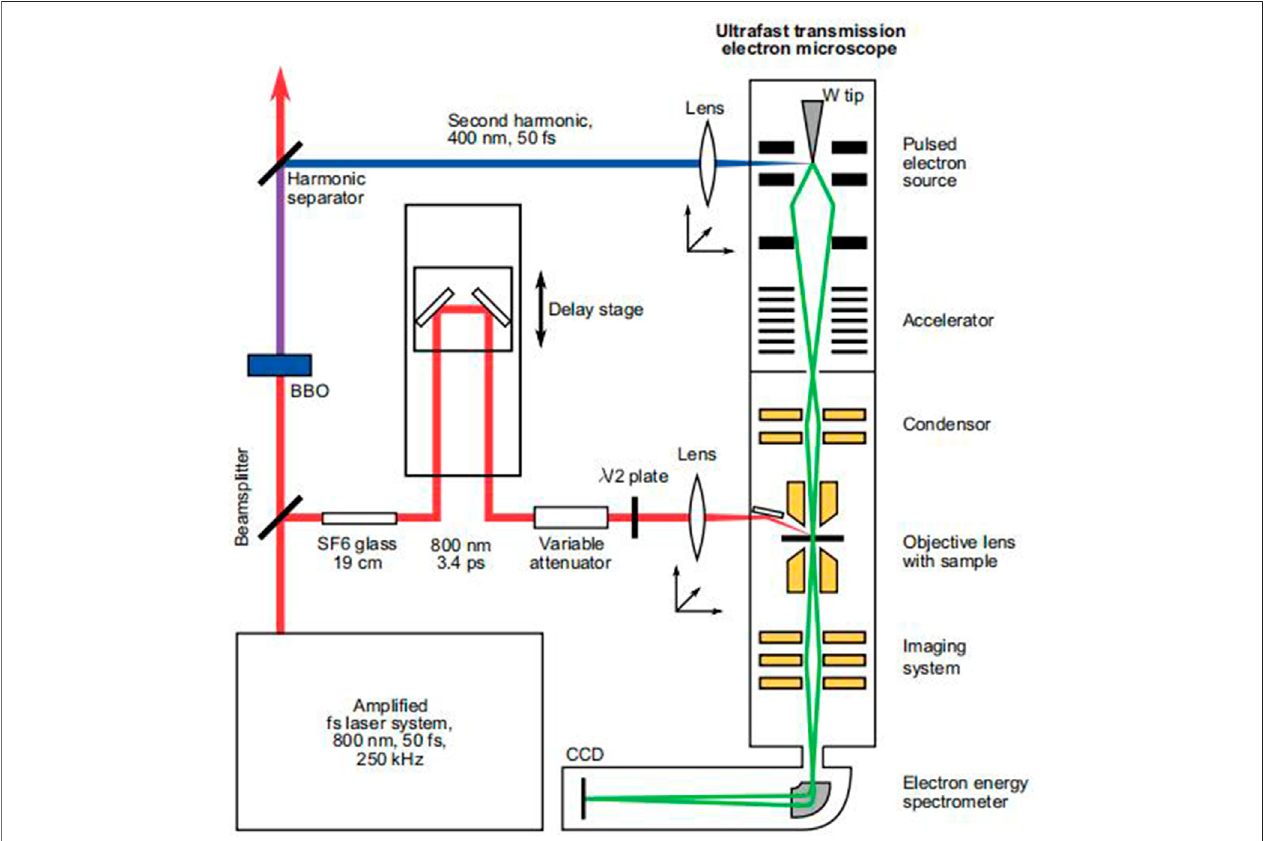
FIGURE 5 | TEM principle diagram (Feist et al.,